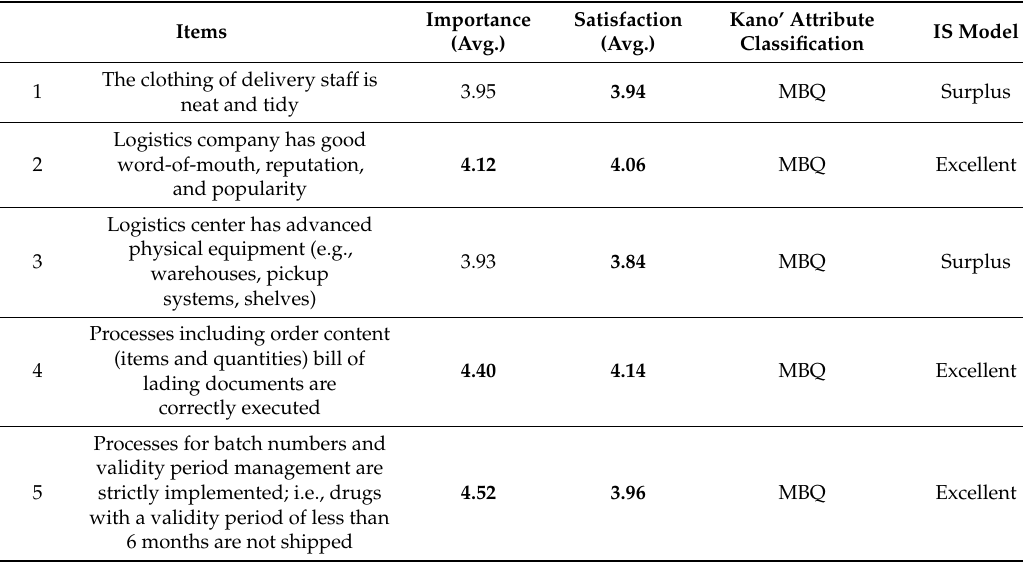
Table 6. Summary of quality elements for pharmaceutical logistics